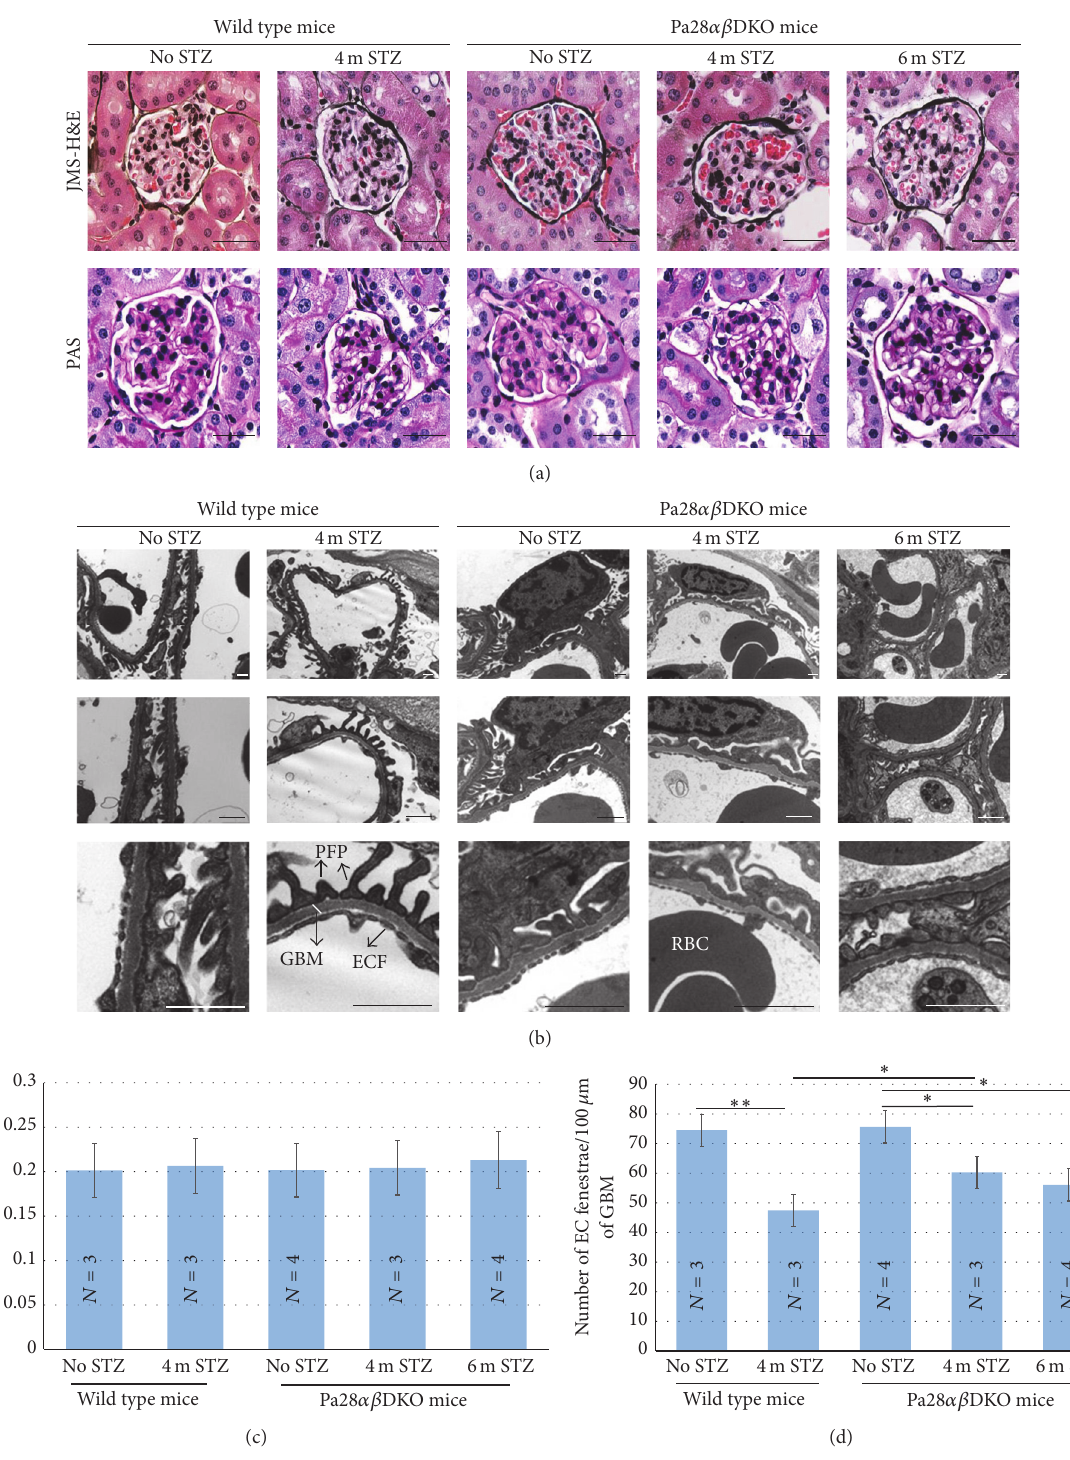
Figure2:LightmicroscopicandTEManalysisoftheglomeruli.(a)JMS-H&EandPASstainingofthenondiabeticandSTZ-diabeticwildtype and Pa28 𝛼𝛽 DKO glomeruli. Scale bars, 30 𝜇 m. (b) Ultrastructure of the glomeruli in wild type and Pa28 𝛼𝛽 DKO mice before and after STZ injection for indicated time points. Glomerular basement membrane (GBM), podocyte foot processes (PFP), endothelial cell fenestrae (ECF), and red blood cell (RBC) are shown. Scale bars, 1 𝜇 m. (c) Quantitation of the GBM thickness in TEM images of wild type and Pa28 𝛼𝛽 DKO glomeruli. (d) Quantitation of the average number of the EC fenestrae in TEM images of wild type and Pa28 𝛼𝛽 DKO glomeruli. N represents the number of animals in each experimental group. Results presented as mean ± SEM. ∗ 𝑝 < 0.05 , ∗∗ 𝑝 < 0.01